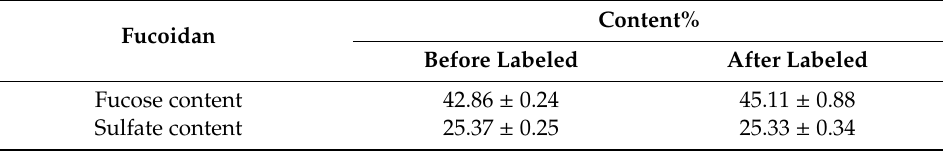
Figure 2. Agarose electrophoresis of fluorescein isothiocyanate-fucoidan (FITC-fucoidan). Table 1. The fucose content and sulfate content of fucoidan before and after being labeled.